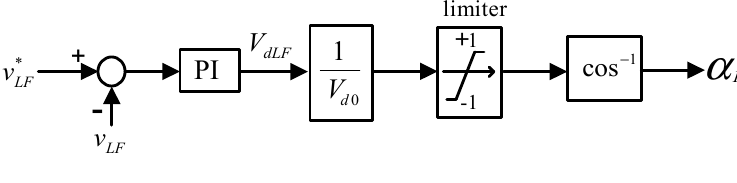
Figure 3. Voltage control of LFAC.